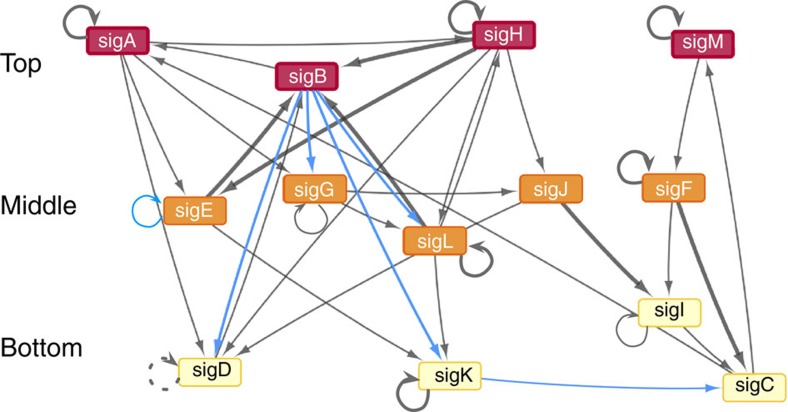
The sigma factor regulatory network of
M. tuberculosis.The interactions identified in the 13 × 13 matrix assay were plotted as a directed network, with the nodes representing sigma factors, and the edges representing direct regulatory interactions. Thick lines represent interactions reported in the literature before the present work (Supplementary Table 1): the autoregulation of sigD, marked with a dashed line, is the only high-confidence link previously detected by multiple assays that was not detected with the E. coli 13 × 13 assay. Thin lines represent novel interactions: in blue are those tested and validated in M. tuberculosis in the present work. The node colours represent three levels of network hierarchical organization, which was estimated using a probabilistic approach (Supplementary Fig. 3).